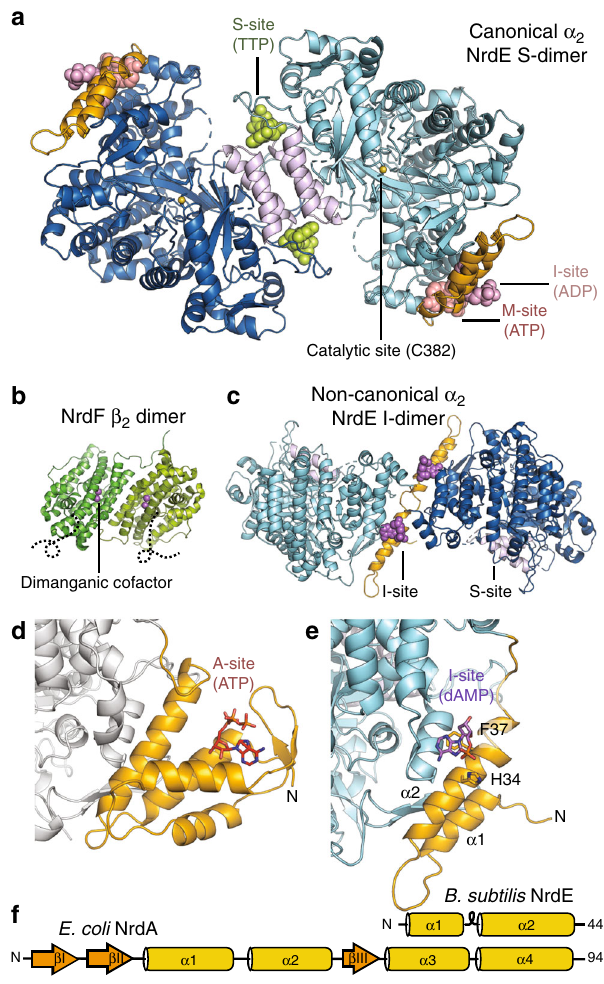
Fig. 1 Allosteric sites of the Bacillus subtilis class Ib ribonucleotide reductase. a A 2.50 Å crystal structure of B. subtilis NrdE ( α subunit) obtained under activating conditions depicts an S-shaped dimer ( “ S-dimer ” ) interfacing at the “ speci fi city ” or S-site (lavender). A speci fi city effector TTP (green) is bound to the S-site, and activating nucleotides, ADP (pink) and ATP (salmon), are bound to two allosteric sites that evolved near the N- terminus of B. subtilis NrdE. A catalytically essential radical is generated at a central cysteine in the catalytic site, C382 (yellow sphere). b B. subtilis NrdF ( β subunit) is dimeric and utilizes a dimanganic tyrosyl cofactor (purple spheres) to initiate radical chemistry (PDB: 4DR0) 21 . A disordered region of the NrdF C-terminus (black dotted lines) is critical for radical transfer. c A recent structure of B. subtilis NrdE co-crystallized with dAMP (purple) depicts a partially inhibited, non-canonical “ I-dimer ” with the interface formed by the truncated ATP-cone (orange) (PDB: 6CGL) 31 . d In class Ia RNRs, ATP or dATP binds to the “ activity ” or A-site in the ATP-cone domain (orange) to mediate changes in quaternary structure and tune overall activity (PDB: 3R1R) 20 . e Class Ib RNRs only contain partial ATP- cones (orange). B. subtilis NrdE is unusual in that it displays activity regulation and binds dAMP (purple) in the N-terminally located I-site (PDB: 6CGL). f The partial N-terminal cone of class Ib RNRs (top) is